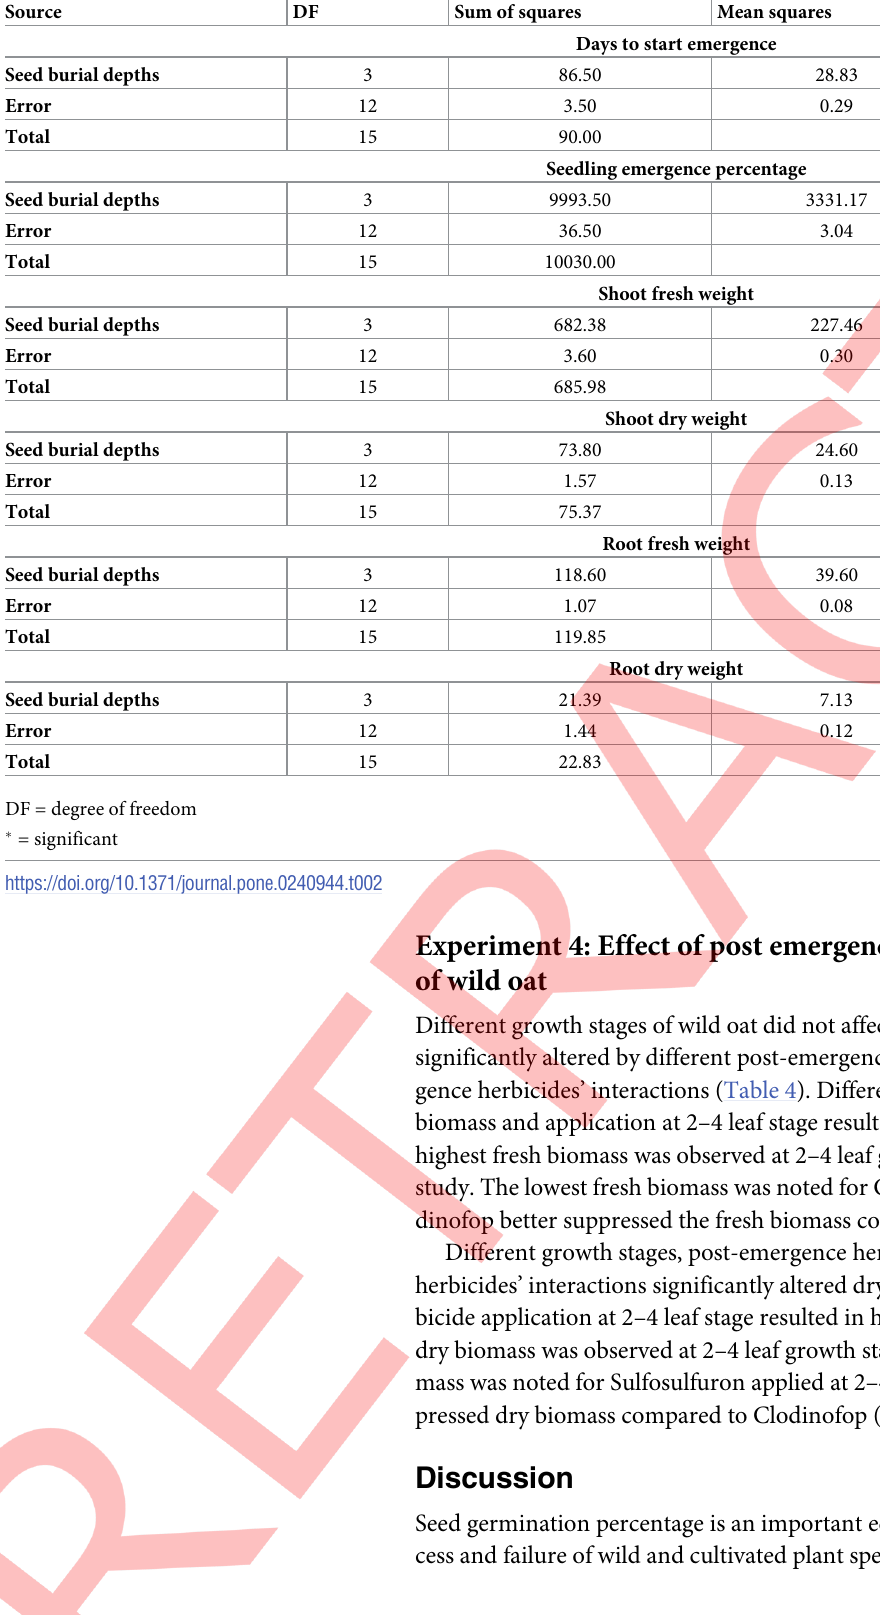
Table 2. Analysis of variance for days to start emergence, root and shoot fresh and dry biomasses of wild oat under different seed burial depths. Source DF Sum of